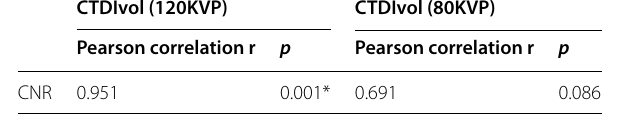
Table 7 Correlation between CTDI